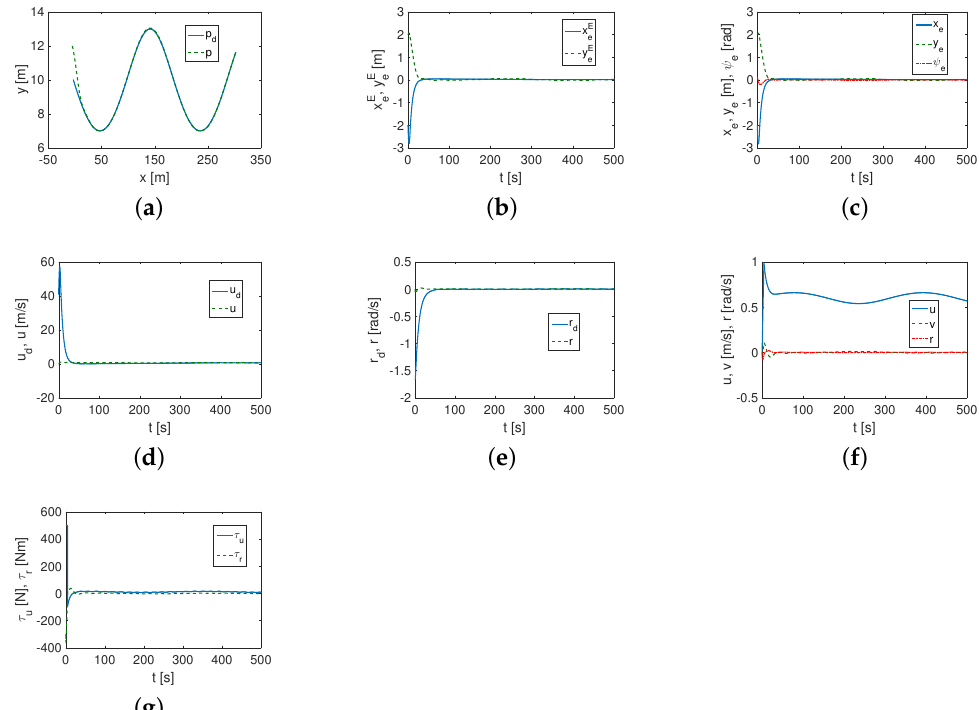
Figure 5. Simulation results for SIRENE—IQV controller and cycloid trajectory (variable distur- bances): ( a ) desired and realized trajectory; ( b ) position errors (E-frame); ( c ) position errors (B-frame) and angular error; ( d ) desired and realized velocity ( u d , u ); ( e ) desired and realized velocity ( r d , r ); ( f ) realized velocities; ( g ) applied force and